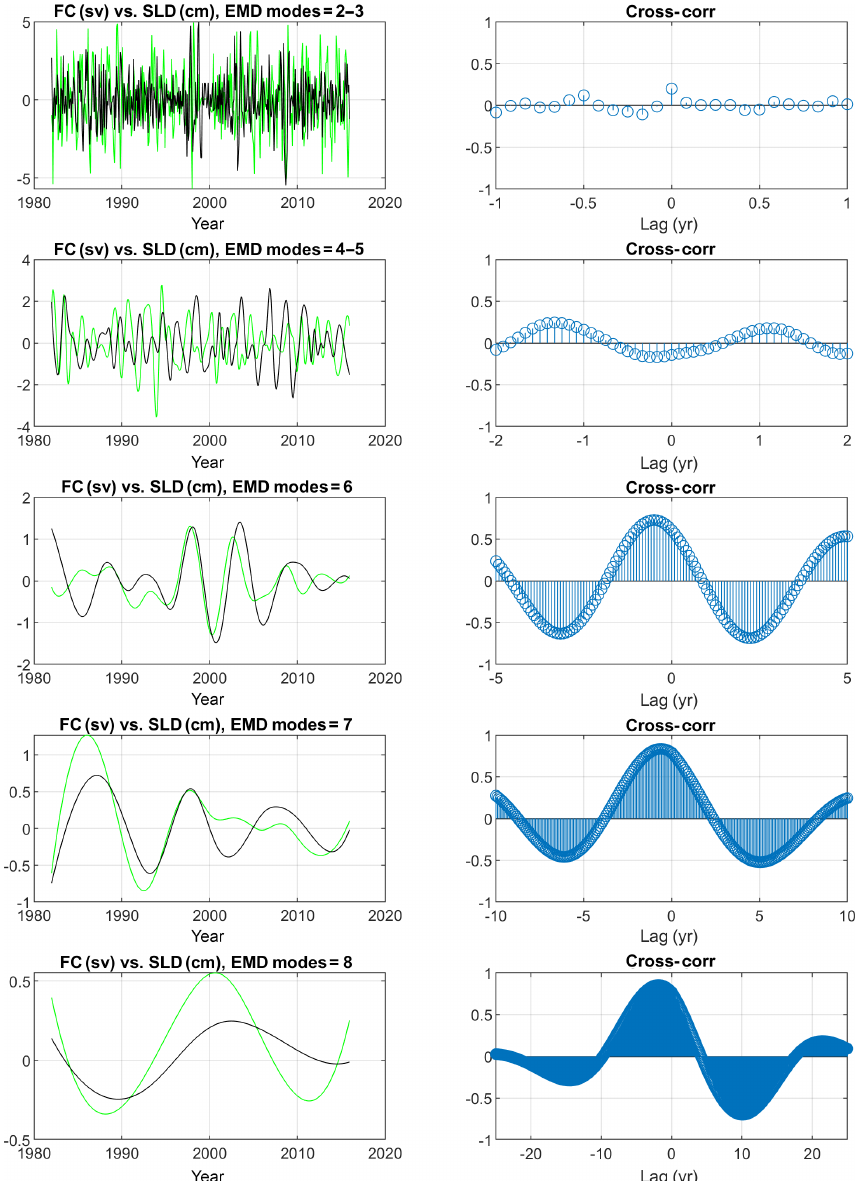
Figure 8. (left) EMD oscillating modes of the observed Florida Current transport (green, in Sverdrups) and GS-SAB proxy from the recon- structed sea level (black, in centimeters). (right) Cross-correlation as a function of lag. High- to low-frequency modes are from top to bottom